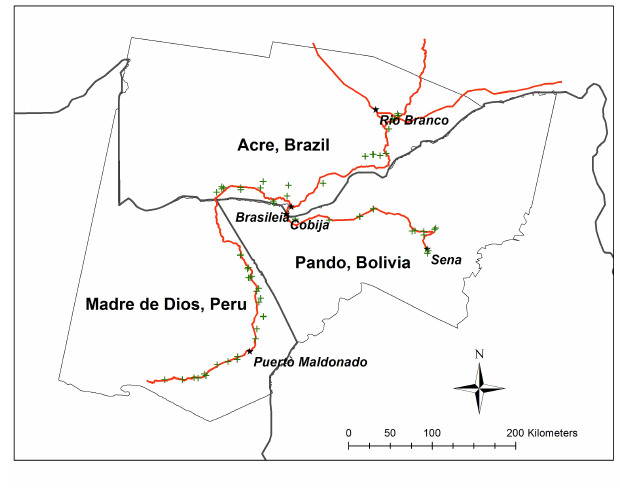
Fig. 1 . A map illustrating the study area in southwestern Amazonia, including major highways (in red), the 69 sample plots (green crosses), and major urban centers